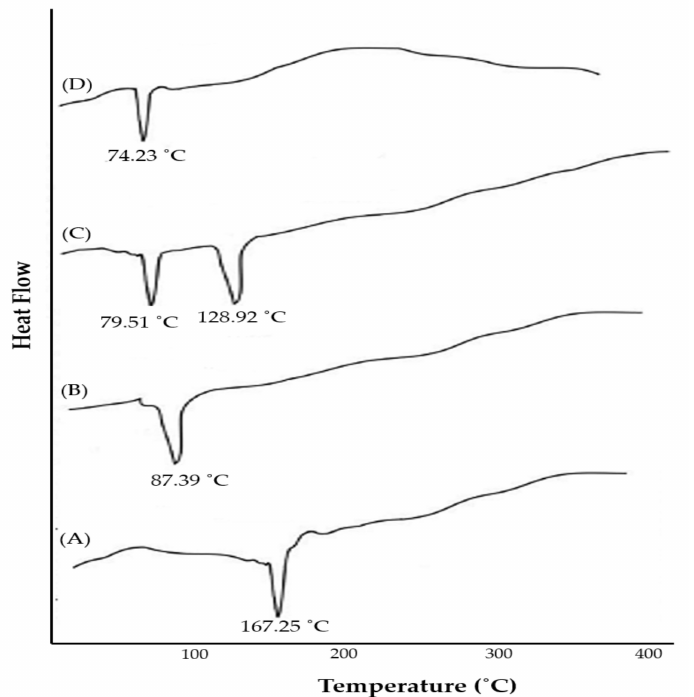
Figure 4. DSC thermograms of ( A ) silymarin; ( B ) SPC; ( C ) physical mixture of silymarin + SPC; and ( D ) optimized silymarin phytosomal